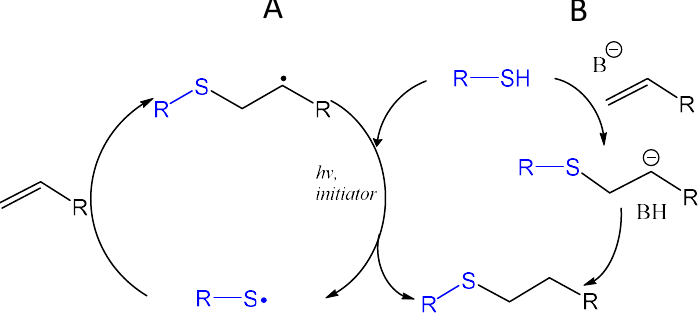
Figure 16. Photoinitiated, radical-mediated thiol-ene addition generates a covalent bond rapidly between a thiol-presenting compound and an alkene ( A ). When electron-deficient alkenes are used, the photoinitiated thiol-ene reaction is often accompanied by the base-catalyzed Michael-type addition reaction ( B ).